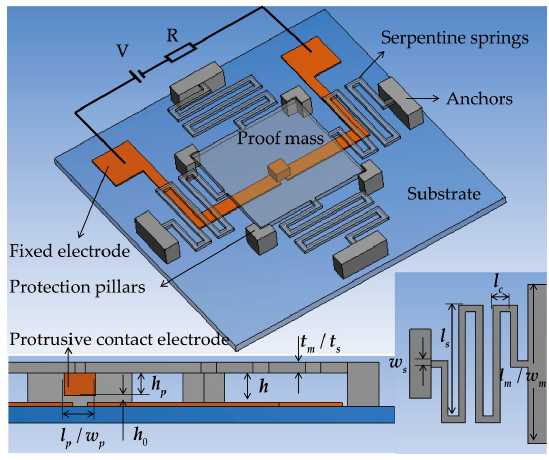
Figure 1. 3-D sketch and main geometric specifications of the micro-switch.